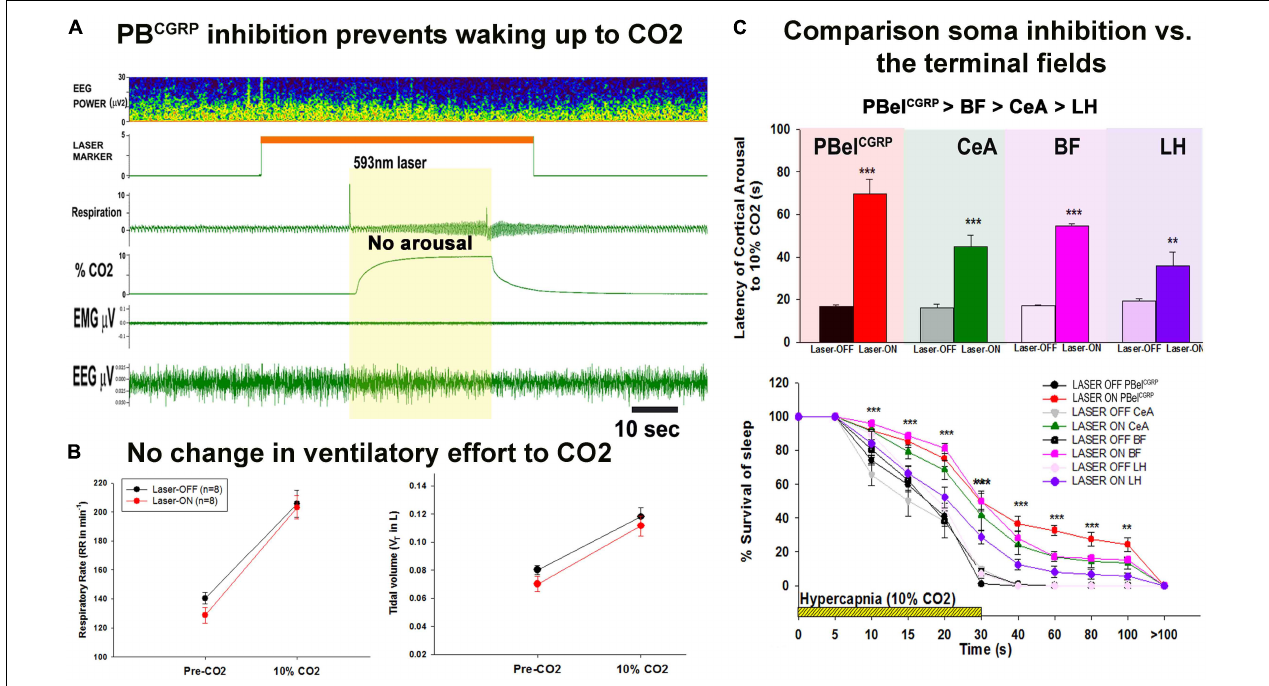
FIGURE 4 | Selective silencing of the PBel CGRP neurons and the terminal fields using Optogenetics: (A) , is the representative recording of EEG, EMG and respiration during the 10% CO2 stimulus in a CGRP-CreER mouse with laser photo-inhibition of PBel CGRP neurons, the mouse in this representative trial did not wake up, and had similar increase in the ventilatory-drive in response to CO2 as the control with Laser-OFF. (B) , Left panel, are the graphs comparing the respiratory rate (RR) and the tidal volume (V T ) (right panel) for 3 breaths before CO2 (Pre CO2) and for 3 breaths during CO2 just prior to waking-up in Laser-OFF and then at the same time point in trials in the same animal with Laser-ON (in which the animals did not awaken). (C) , Compares the effects of PBel CGRP soma inhibition to that of PBel CGRP terminals field inhibition (A) , latency of arousal mean (SEM) during laser (593 nm) induced inhibition of the PBelCGRP neurons is compared with inhibition of the terminal fields in the BF, CeA, and LH. (B) Survival of sleep curves during and after a hypercapnic stimulus shown with and without laser. ( ∗∗∗ p < 0.0001; ∗∗ p < 0.001; 1-way or repeated measures ANOVA followed by Holm-Sidak for multiple comparison). [Adapted and modified from Kaur et al. (2017)]. Kaur et al. (2017) is published in a Cell Press journal “Neuron,” and no permissions needed to reproduce the modified versions of the published figure.